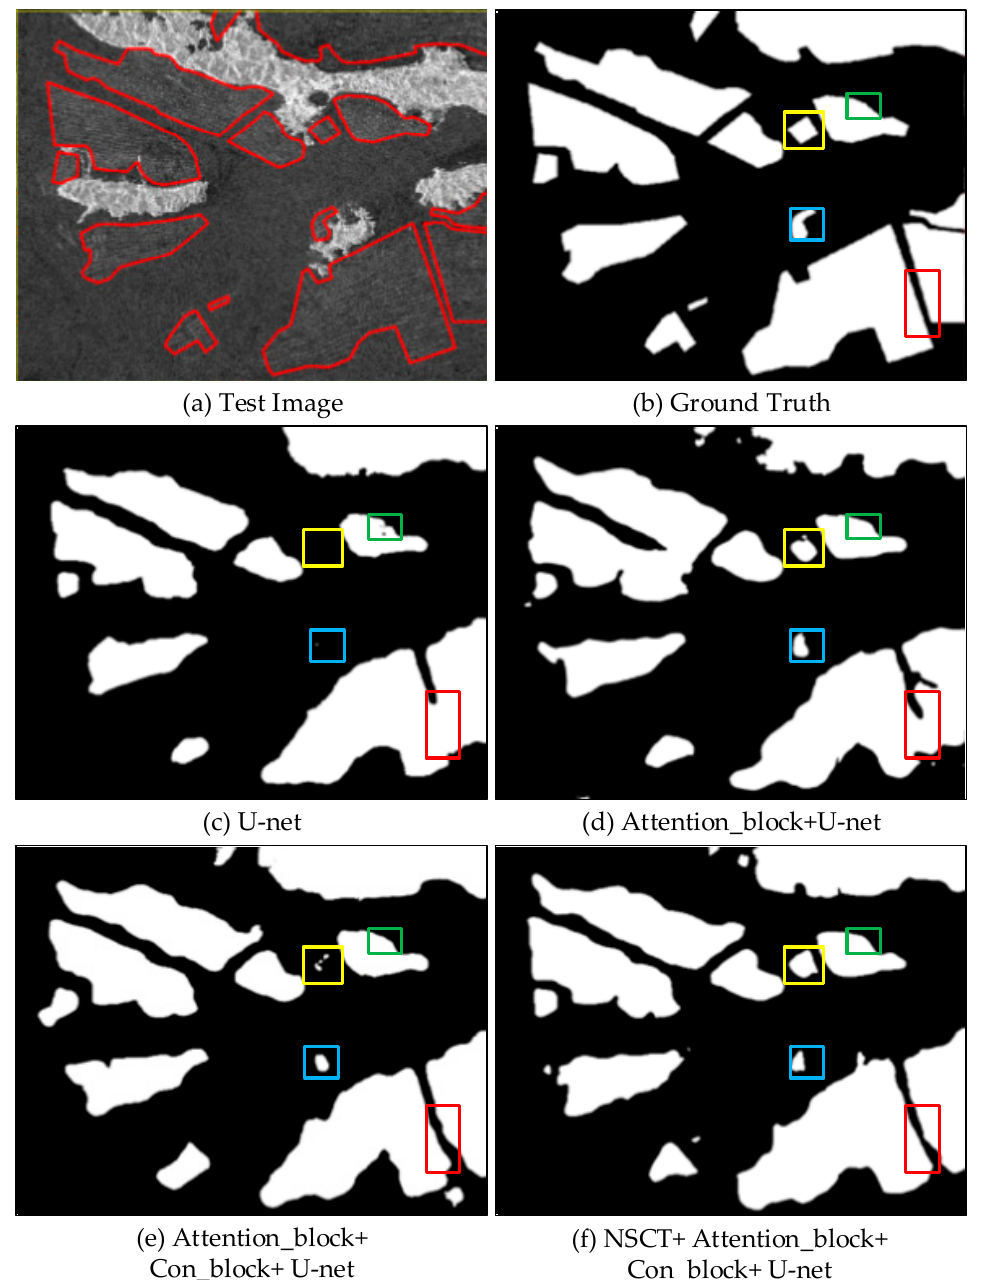
Figure 14. Results of the ablation experiment for a subset of the study area. ( a ) Test image. ( b ) Ground truth. ( c ) The results obtained by the original U-net. ( d ) The results obtained by the network that introduced the attention layer. ( e ) The results obtained by the network that modified the convolutional structure. ( f ) The results obtained by the proposed method.